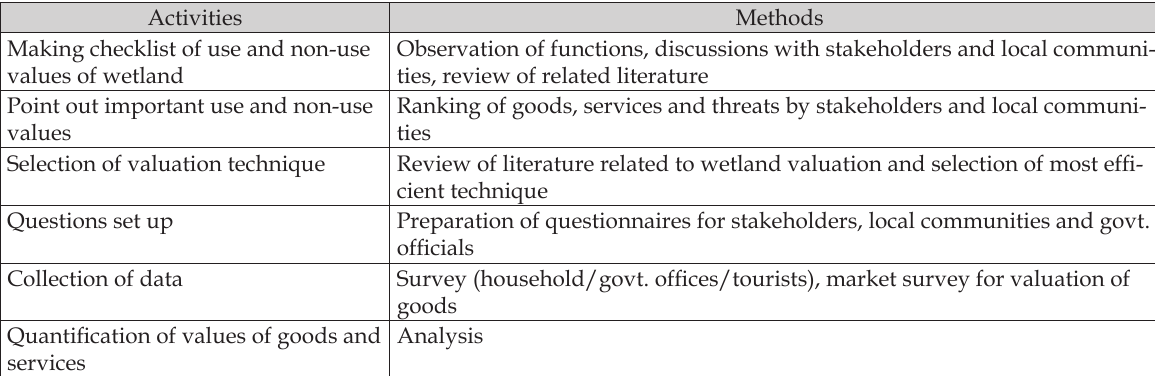
Table 2. Steps followed for the valuation of the wetland.